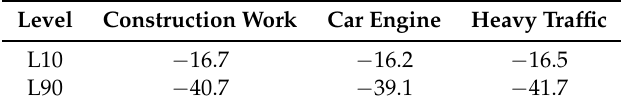
Table 1. Statistical noise levels in decibels relative to full scale (dBFS)